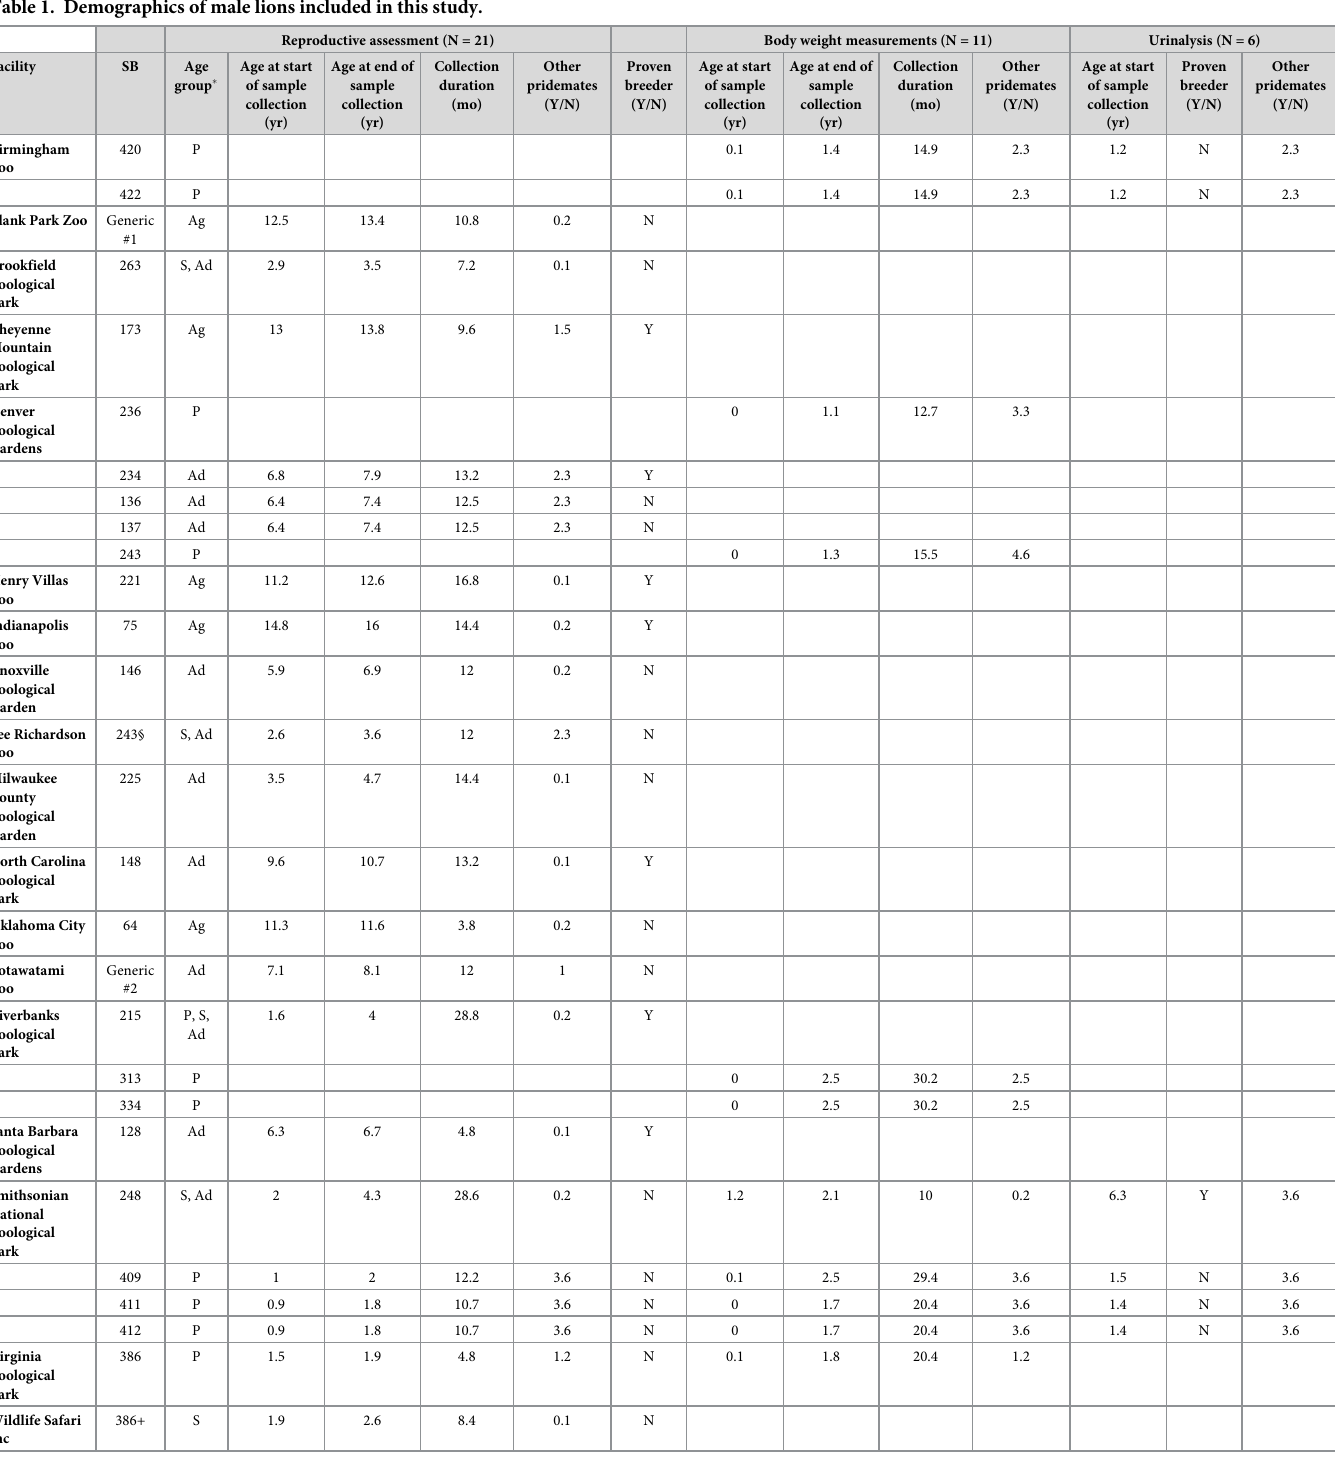
Table 1. Demographics of male lions included in this